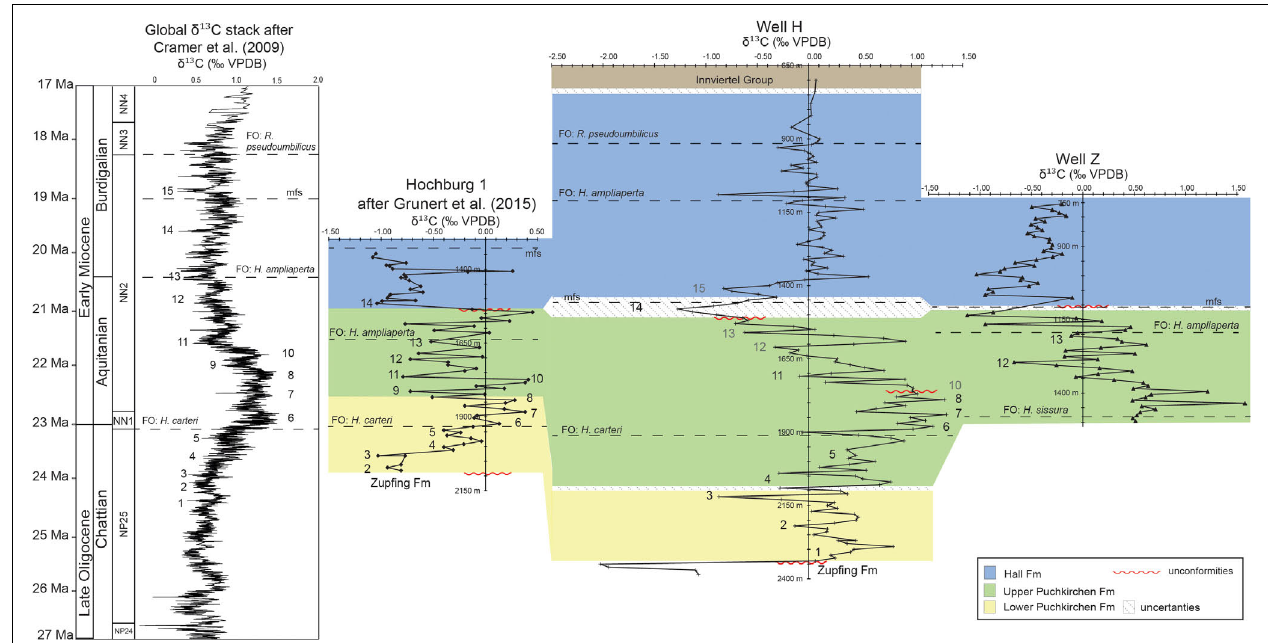
FIGURE 9 | Correlation of δ 13 C carb data from the Upper Austrian NAFB (Hochburg1, Well H and Z) and the global stack of Cramer et al. (2009). Numbers indicate minima and maxima in the global stack that are used for correlation. FO of Helicosphaera ampliaperta, Helicosphaera carteri, and Reticulofenestra pseudoumbilicus are shown. Maximum flooding surface (mfs) is taken from Grunert et al. (2013) in Hochburg1 and correlated by seismic interpretation to Well H and Z.